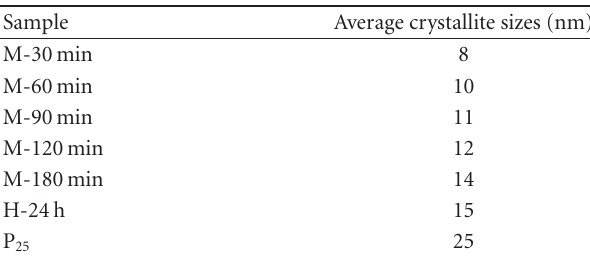
Table 1: The calculated average crystallite sizes of CeO 2 -SiO 2